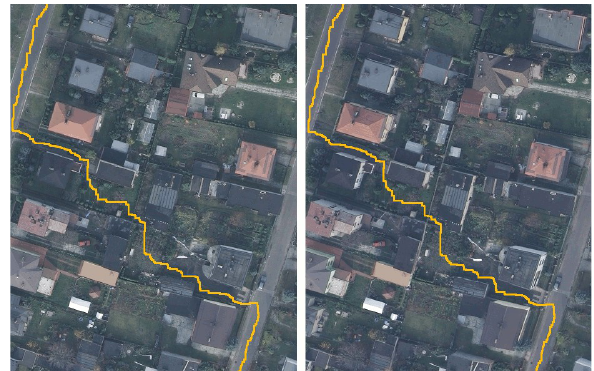
Figure 6. An example of routing the seamlines in a suburban area – against the background of the left and right orthoimages